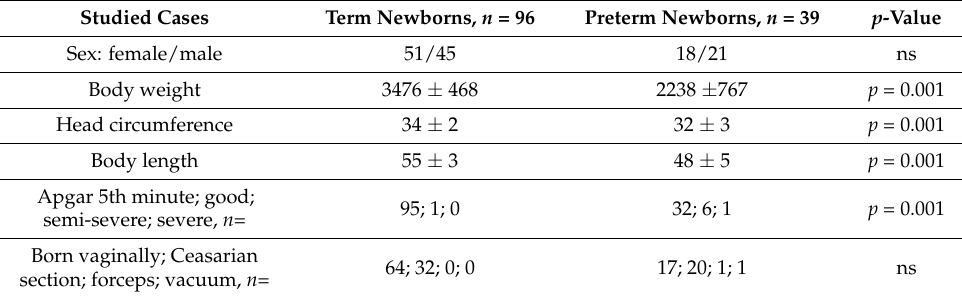
Table 1. Demographic characteristics of the studied newborns.